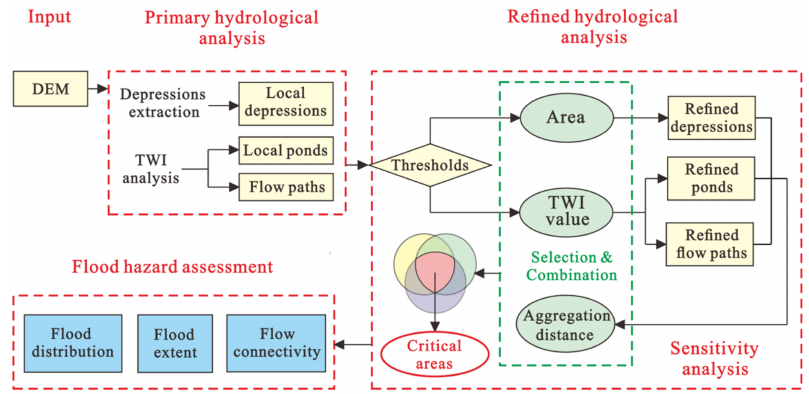
Figure 1. Workflow of the GIS-based characterization of the flood-prone